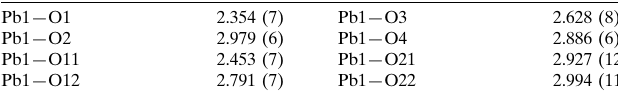
Selected bond lengths (A˚ ).